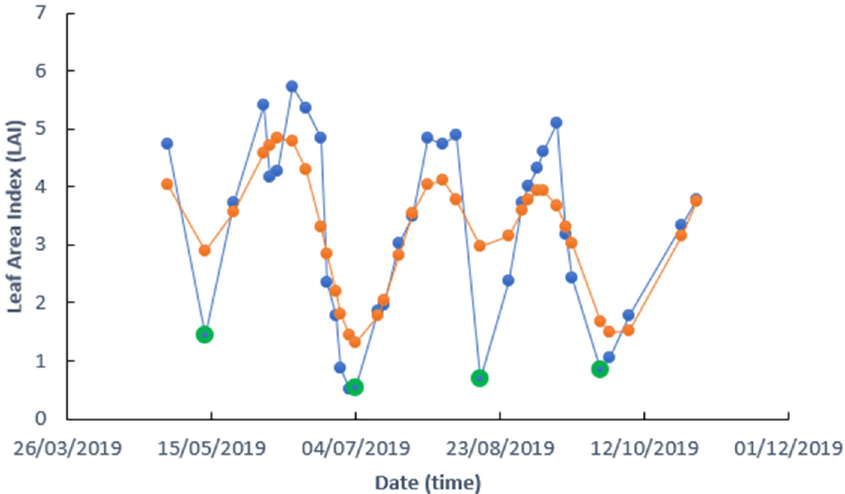
Figure 9. Observed signal (blue) and smoothed (orange) LAI time series of an IPG pixel showing two mowing events (green dots).